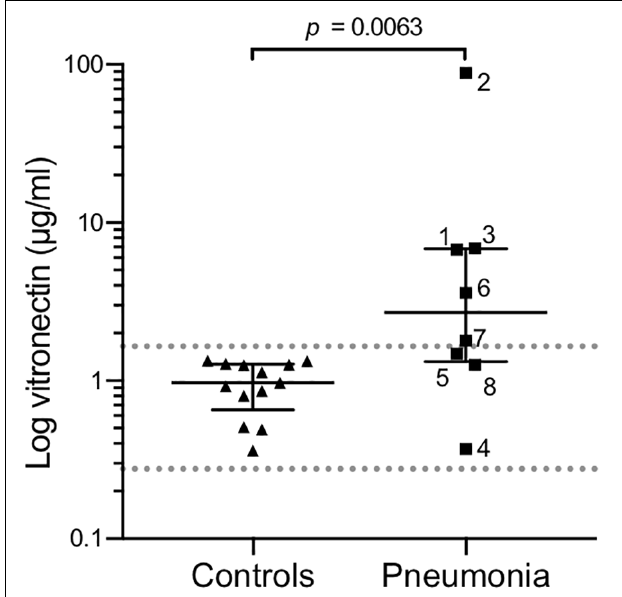
FIGURE 1 | Bronchoalveolar lavage fluid (BALF) samples from patients with pneumonia contain elevated extracellular vitronectin concentrations. BALF samples were collected from patients with pneumonia ( n = 8) and healthy control subjects ( n = 13). Vitronectin concentrations were determined by ELISA, with higher values reflecting higher vitronectin concentrations in the bronchoalveolar space. Each point represents one study subject, with triangles representing healthy subjects and squares representing patients with pneumonia. Numbers next to squares refer to the study ID of pneumonia patients. Median and interquartile values are marked with horizontal lines. The dotted lines represent the study-specific reference range (mean ± 2SD) of healthy controls. p -values were determined using the Mann–Whitney test.